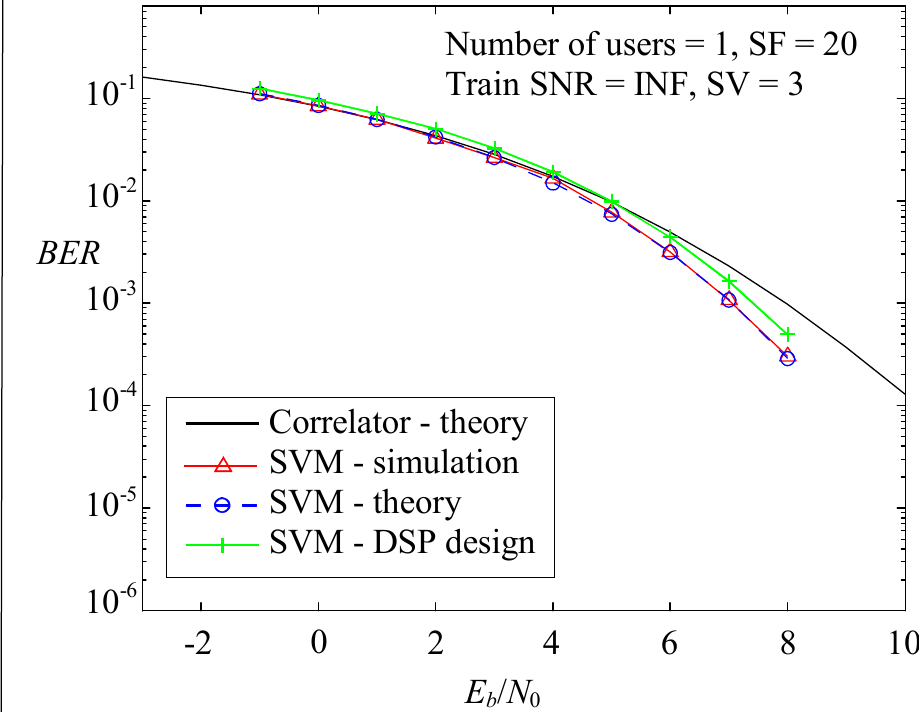
Figure 5 – BER curves, theoretical, simulated and DSP results for the system with the SVM for 1 user Рис . 5 – Кривые вероятности битовой ошибки (BER), полученные при теоретическом моделировании и DSP результатах для системы SVM с одним